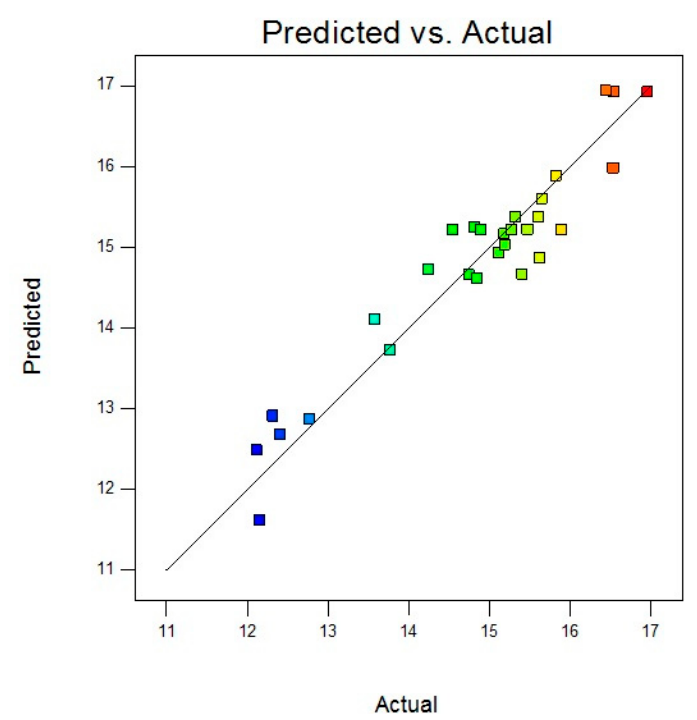
Figure 3. Correspondence plot of predicted and actual values of CNF yield